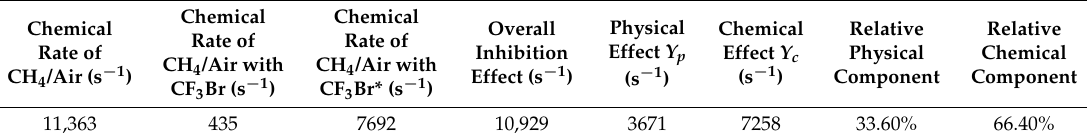
Table 1. The overall effect/chemical effect/physical effect of 3.5% CF 3 Br added to stoichiometric CH 4 /air flames at 298 K and 1 bar.